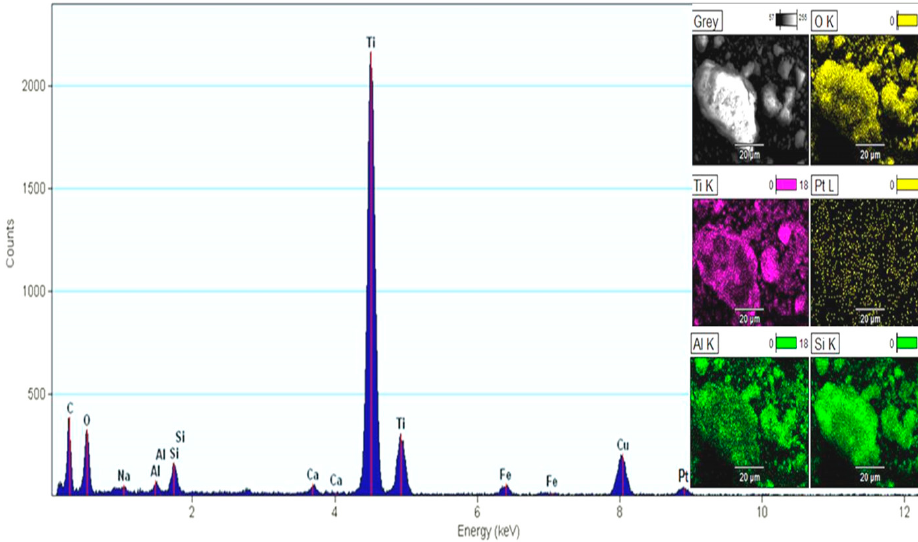
Figure 7. EDX spectrum and mapping images of FADPt.